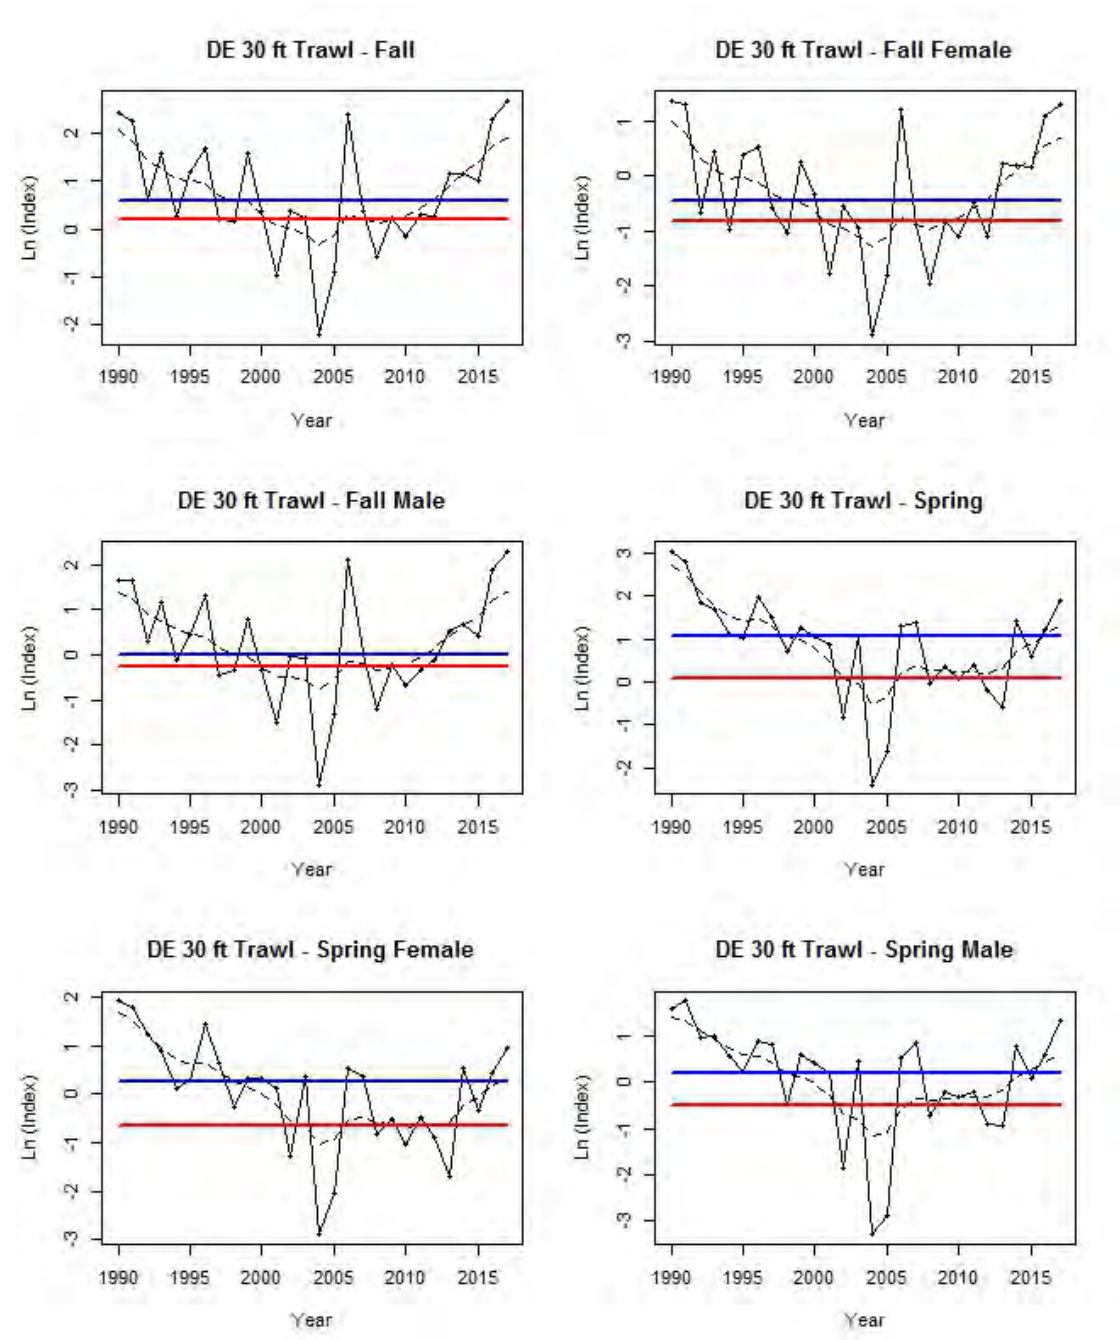
Figure 85. ARIMA model fits to horseshoe crab indices from the DE 30 ft. Trawl survey in the Mid-Atlantic Region. The solid line represents the observed ln transformed indices and the dashed line represents the fitted indices. The red horizontal line represents the Q 25 reference point and the blue horizontal line represents the 1998 reference